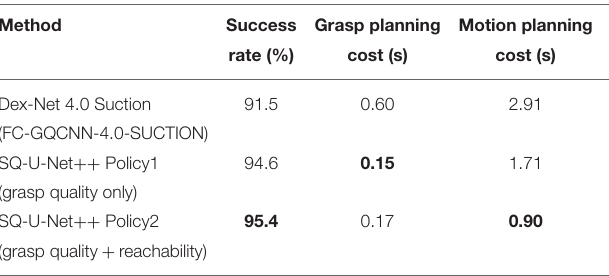
TABLE 2 | Experiment results.